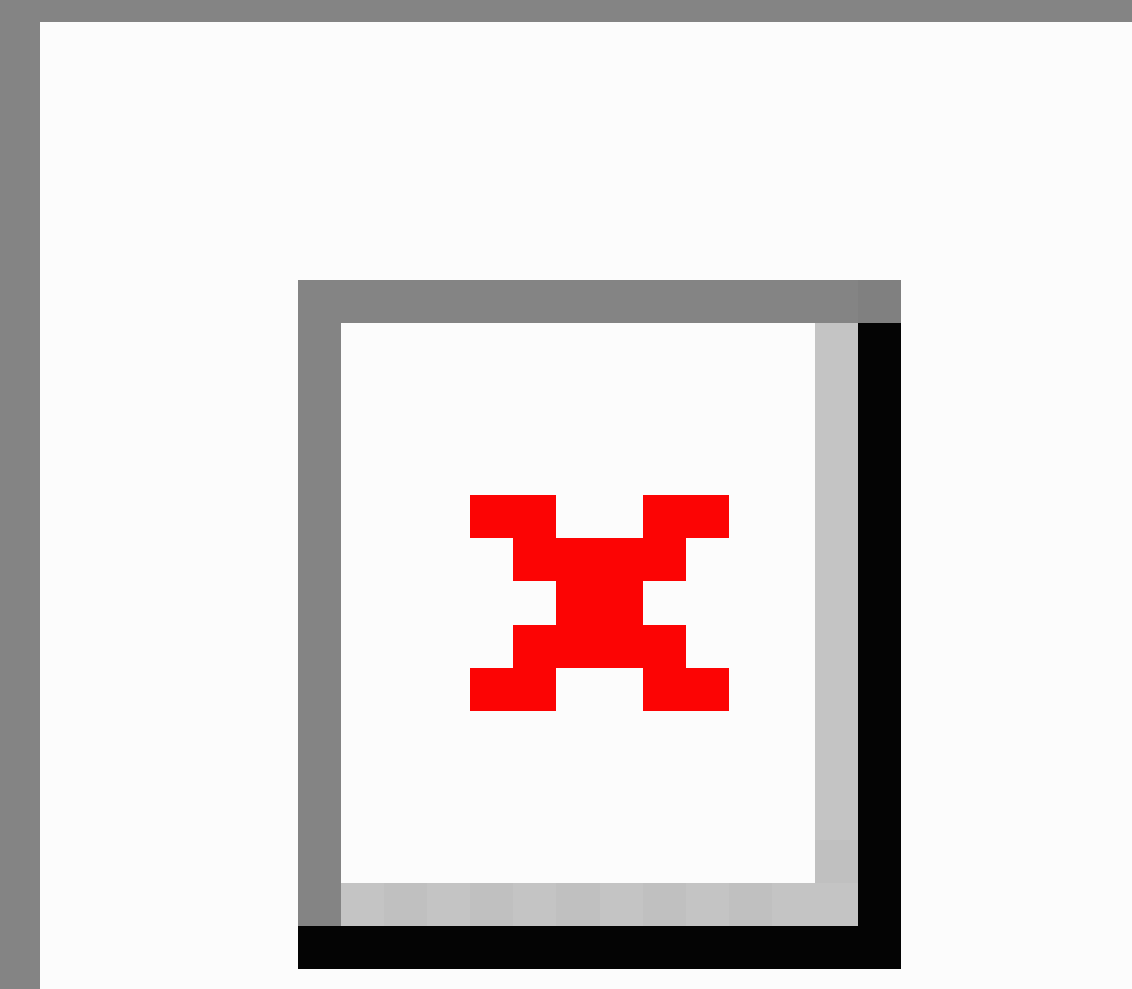
Figure 1. Flowchart of the intervention (I) and control (C) subjects in the RCT. Note that for analysis of the primary outcome measure at t1, 2 out of 48 (4%) and 1 out of 50 (2%) participants in the intervention and control group respectively, were excluded for analysis due to impossible values for physical activity (not shown in figure, see text under "Primary Outcome